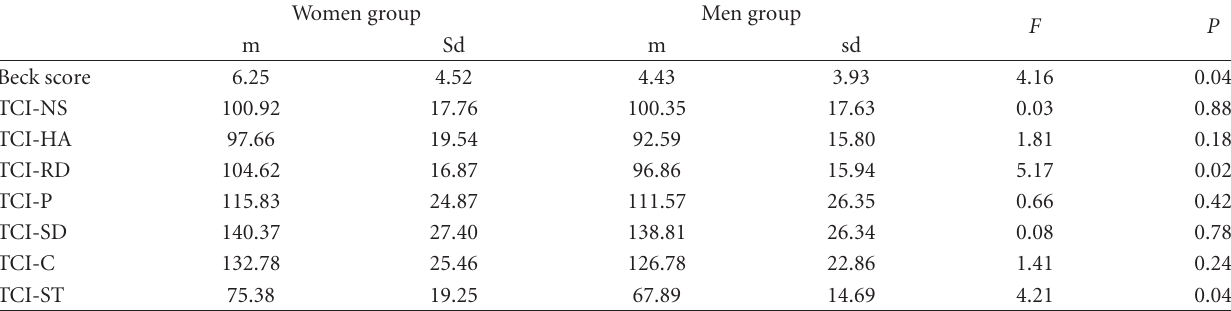
Table 2: ANOVA between women and men groups on Beck and TCI scores.